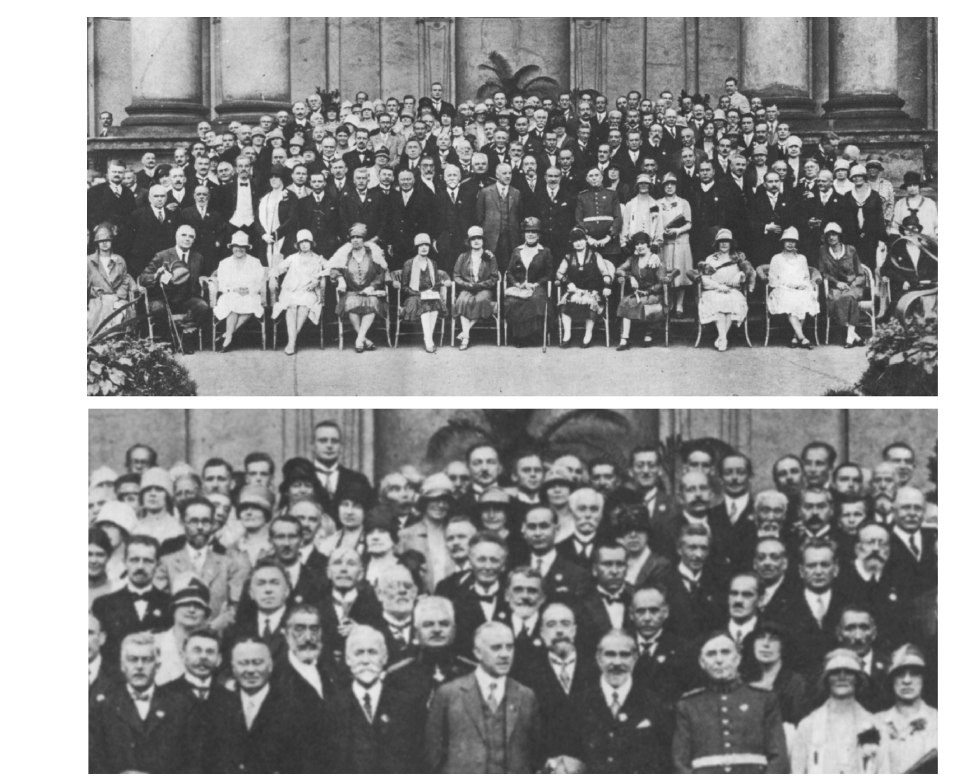
Figure 4. Participants of the Third General Assembly (upper panel); details of the central part of the photo (lower panel) (source: IUGG